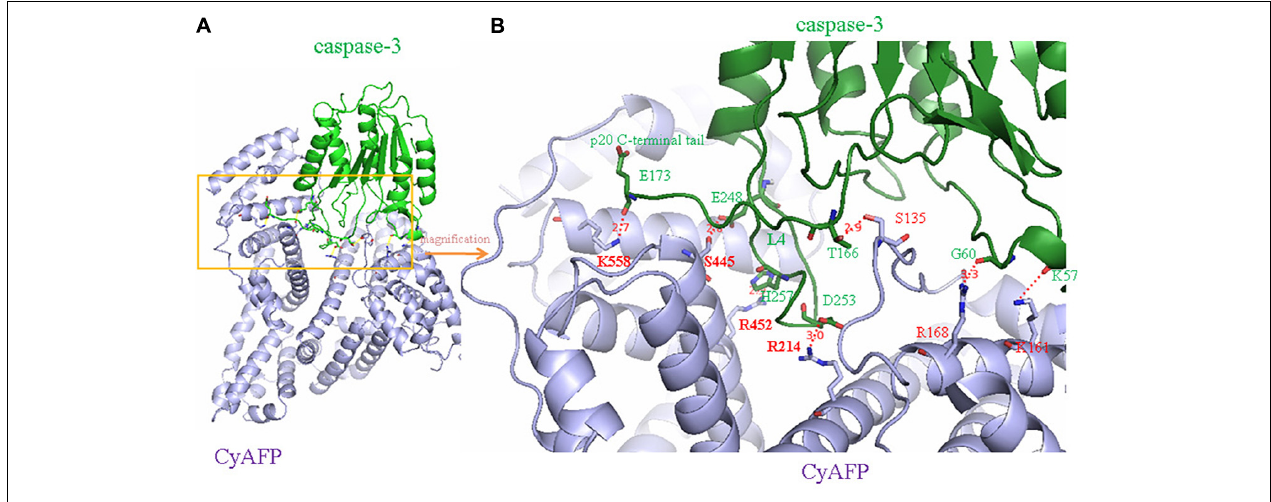
FIGURE 2 | A molecular structure model of the interaction of CyAFP with caspase-3. (A) Overall structure of CyAFP in complex with caspase-3. CyAFP (blue) binds to caspase-3 (green) in the hydrophobic pocket. (B) Residues of CyAFP interact with caspase-3 (Lin et al.,